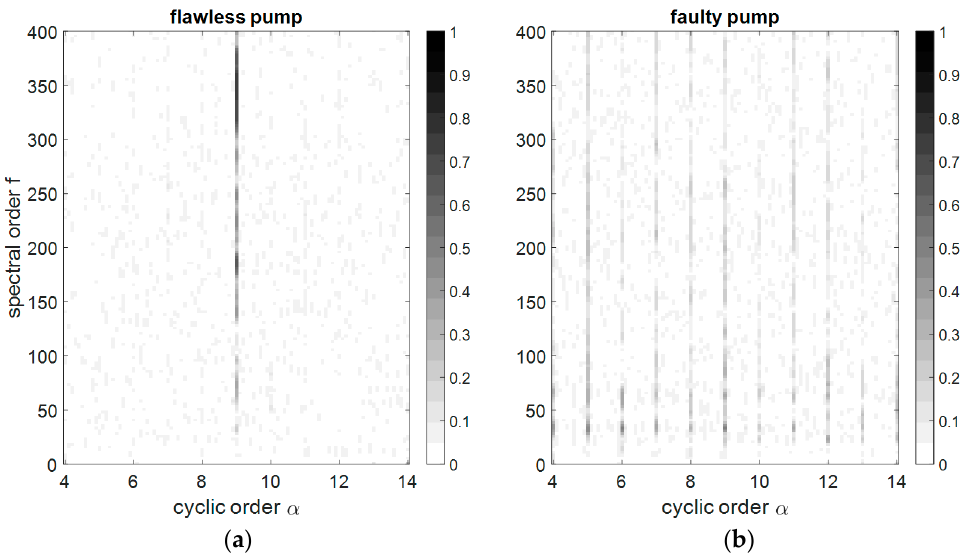
Figure 15. CSC around the cyclic order 9 for the signals acquired with sensor 2 at 1500 r/min and 150 bar ( ∆ α = 0.1, ∆ f = 2.5). ( a ) flawless pump; ( b ) faulty pump.